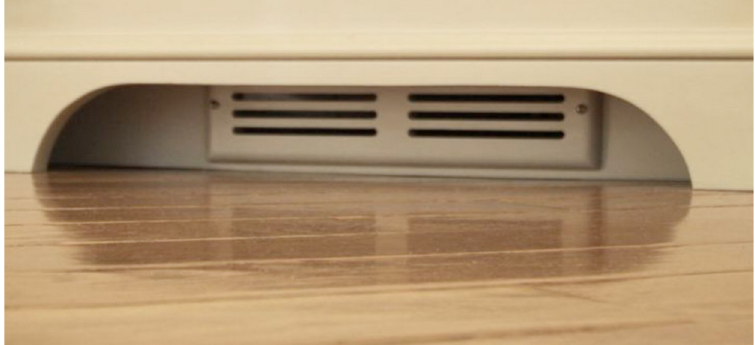
Fig. 5. Ventilation main handrail with special design.